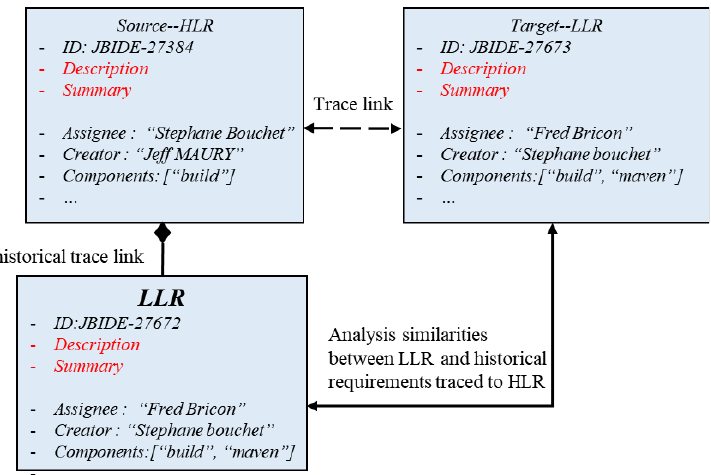
Figure 1. Example: indication effect of requirement process data for the creation of a trace link.